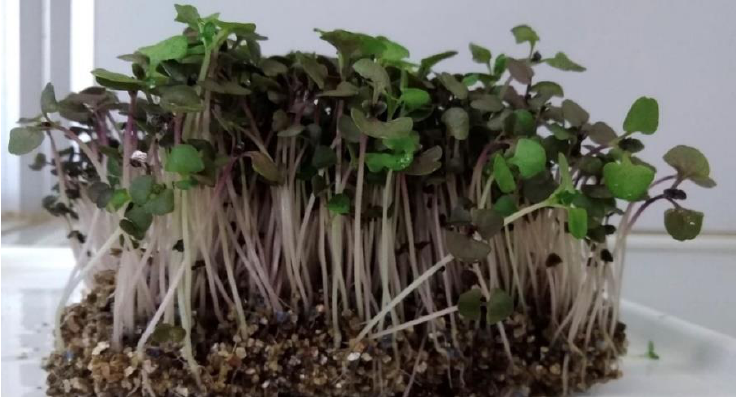
Figure 12. Red basil microgreens grown on vermiculite substrate. This species reached the highest levels of phenolic compounds.